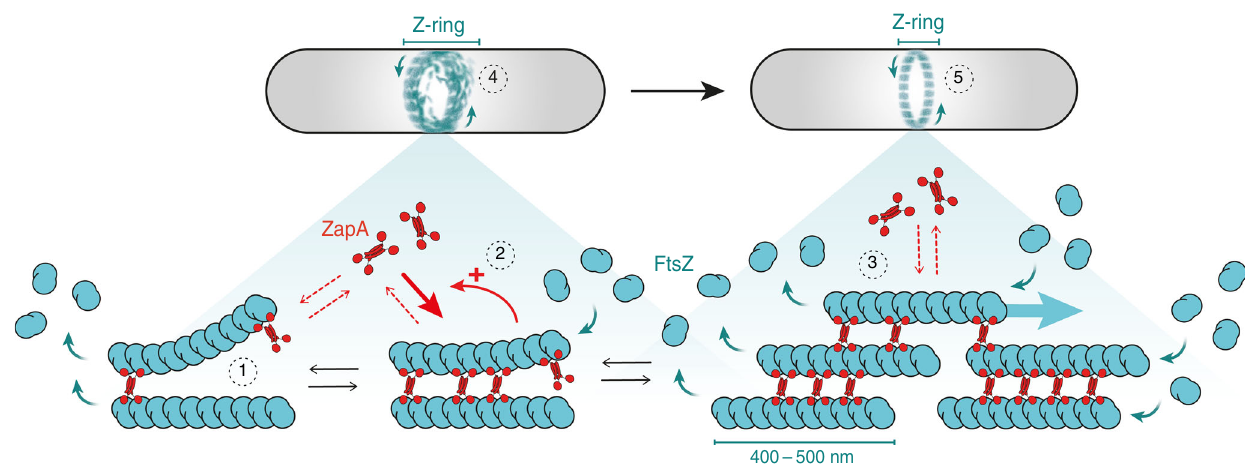
Fig. 8 A model for the in fl uence of ZapA and its role for Z-ring maturation. Binding of ZapA aligns treadmilling FtsZ fi laments (1), which in turn facilitates its binding, giving rise to cooperativity (2). At saturation, four molecules of FtsZ bind to one tetramer of ZapA (1:1 monomer ratio, [FtsZ] = [ZapA]) in parallel increasing the bundle width, persistence and alignment of FtsZ fi laments (3). Treadmilling is not affected due to the transient binding of ZapA. Together, ZapA leads to a shift from a network of less ordered and highly dynamic FtsZ fi laments (4) into a more well-de fi ned track, acting as an additional fi ne-tune mechanism for a proper Z-ring alignment (5) without compromising treadmilling